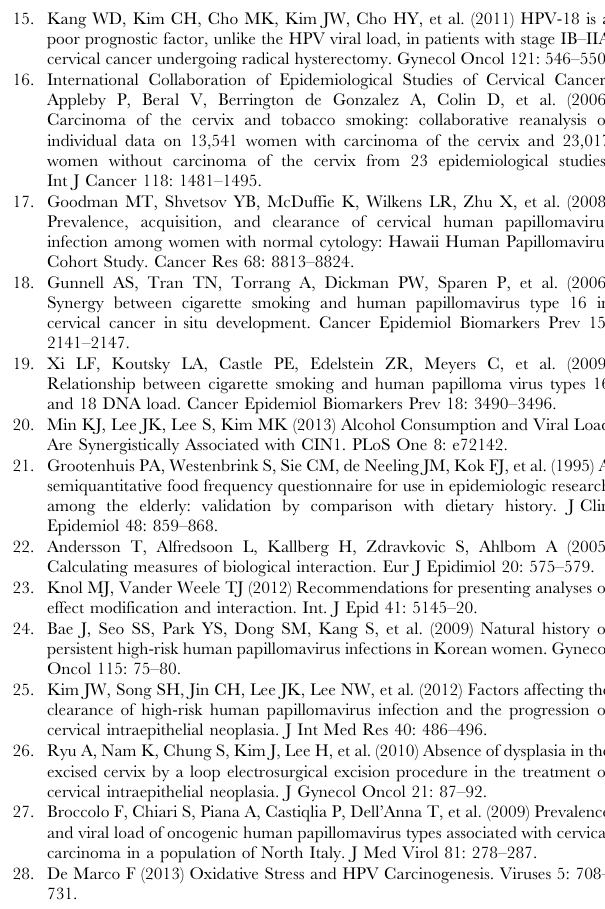
Table S2 Interaction between high HR-HPV load and